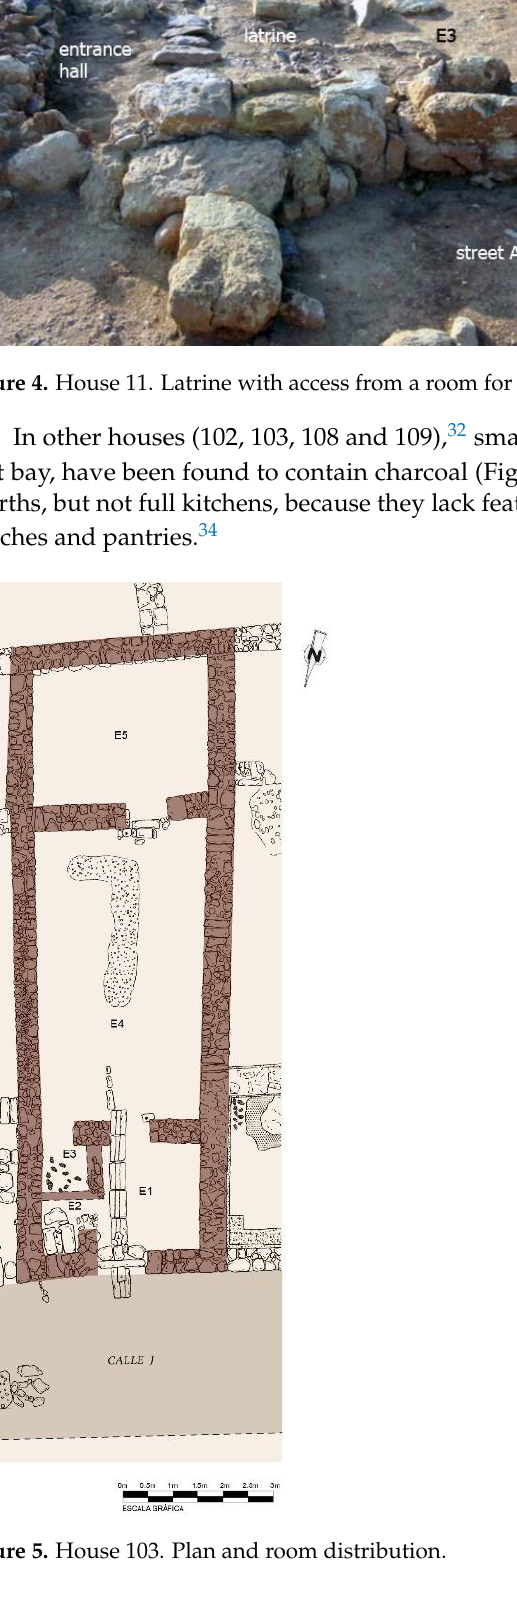
Figure 5. House 103. Plan and room distribution.